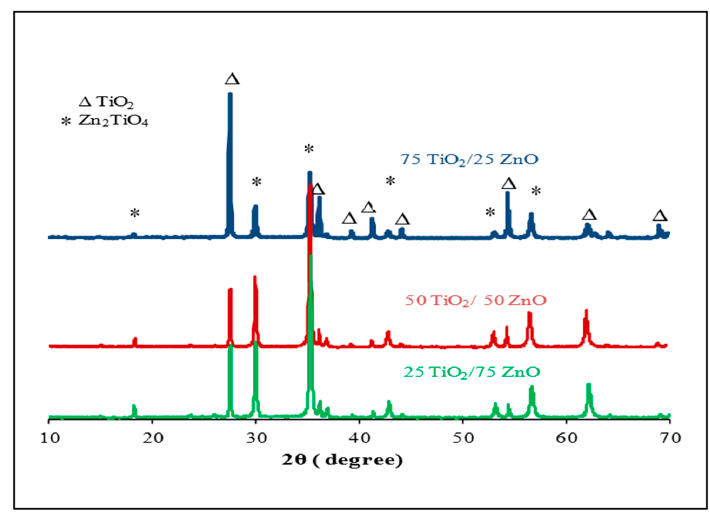
Figure 4. The XRD patterns from 10° to 70°, 2 θ , for TiO 2 /ZnO samples, after being heated at 1250 °C for 5 h.